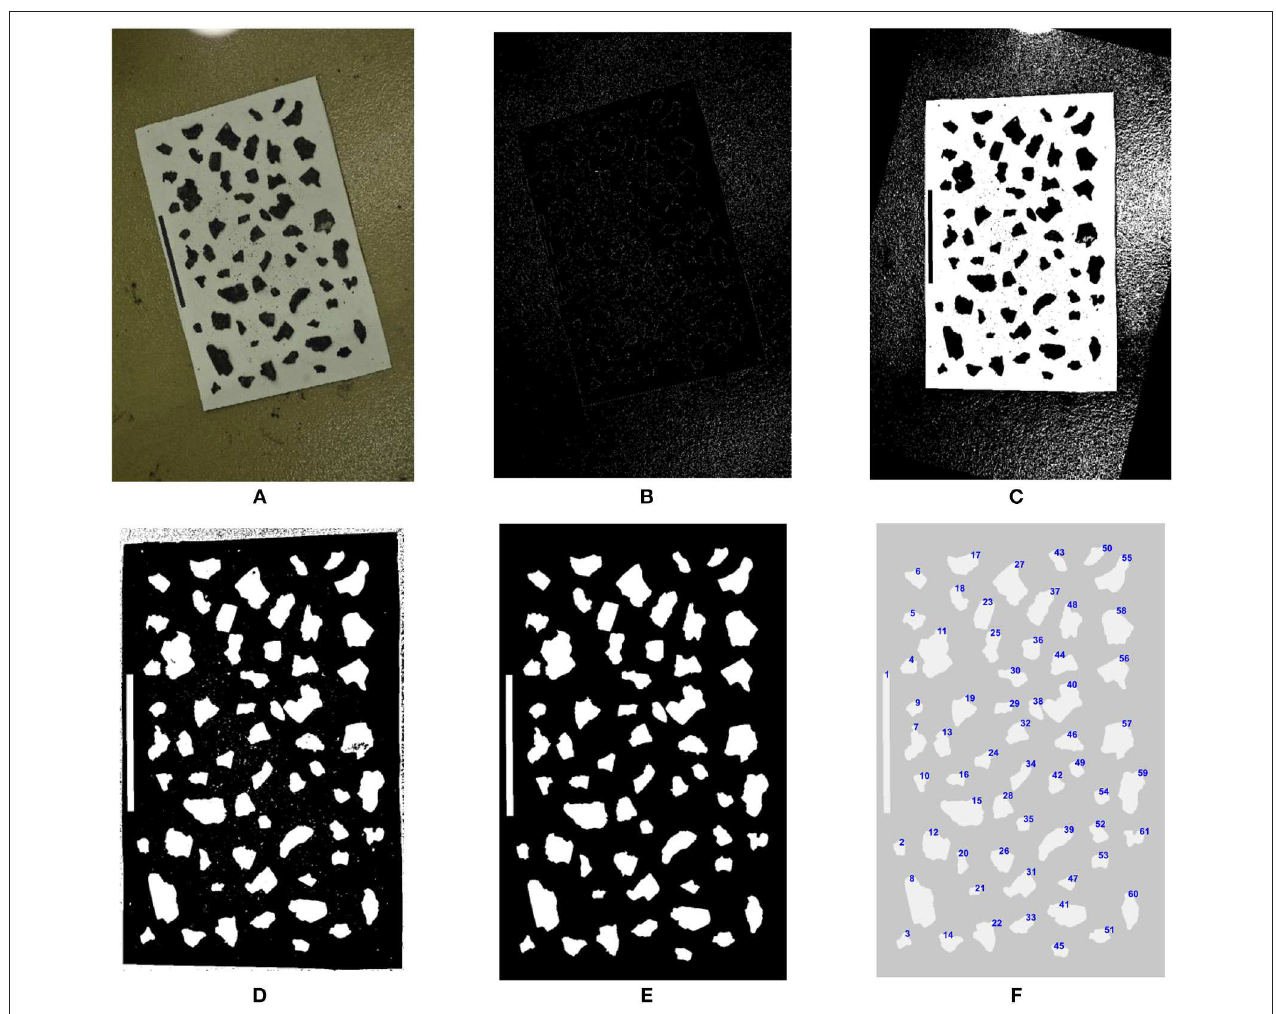
FIGURE 3 | Detailed steps to calculate the projected area. (A) Original image. (B) Edge detection. (C) Rotation. (D) Corner detection and cropping. (E) Noise removal. (F) Labeling firebrands with known projected